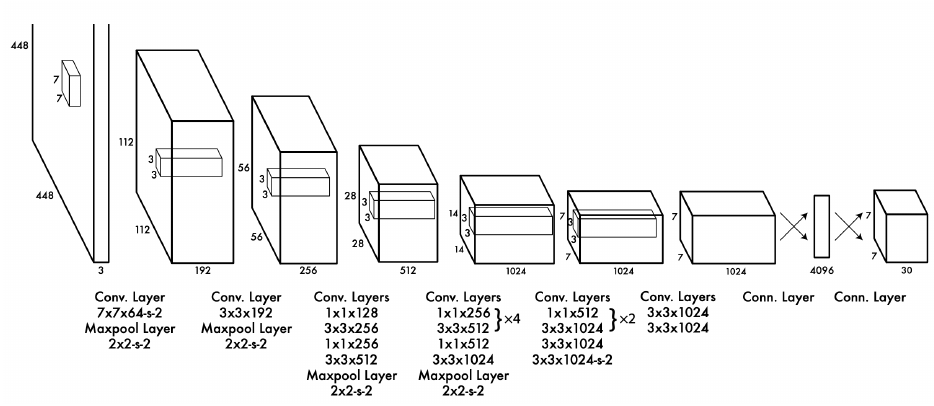
Figure 4. The architecture of YOLO